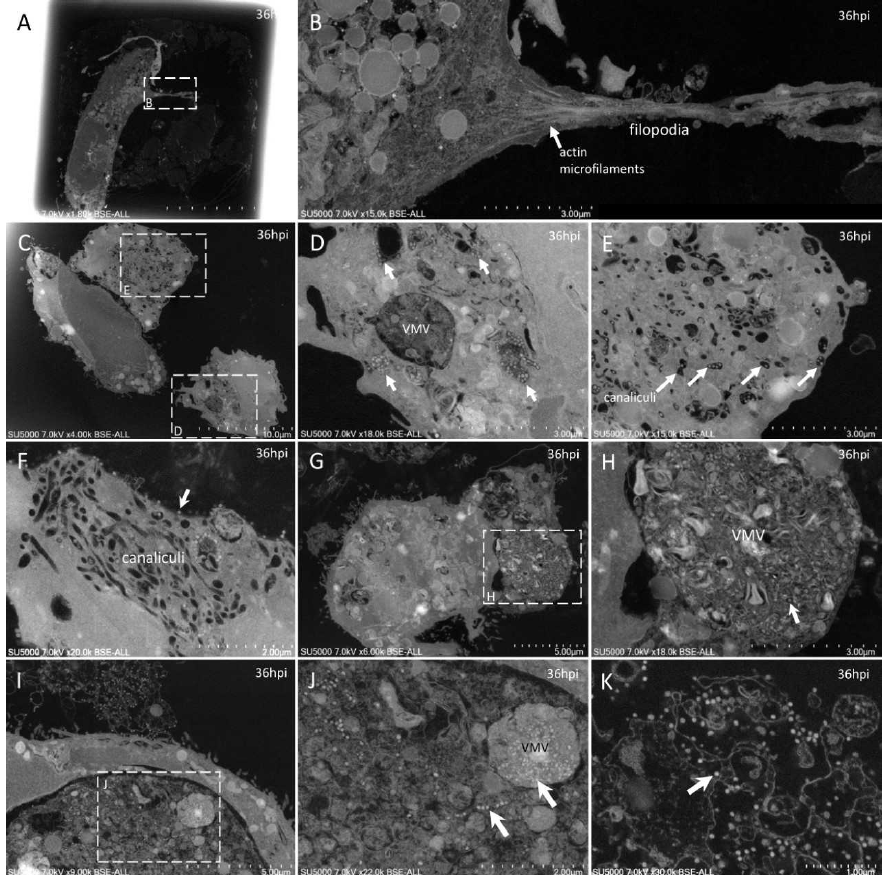
Figure 7. Ultra-thin sections of SARS-CoV-2-infected Vero E6 cells: 36 hpi. ( A , B ): A cell with a filopodia ( B ) containing actin microfilaments (arrow); SARS-CoV-2 virions were not detected inside such filopodia structures. ( C – F ): Cells with SARS-CoV-2 particles inside a virus-morphogenesis vesicle (VMV) or inside tubules/vesicles of the canaliculi system ( D , E ; arrows) or at the plasma membrane ( F ; arrow). ( G , H ): Large VMV containing SARS-CoV-2 virions (arrow) and membranes. ( I – K ): In adjacent cellular regions, SARS-CoV-2 particles (arrows) were found concentrated in a VMV, disseminated in a larger vacuole ( J ; arrows), or stitched extracellularly to the plasma membrane remnants of a lysed cell ( K ).